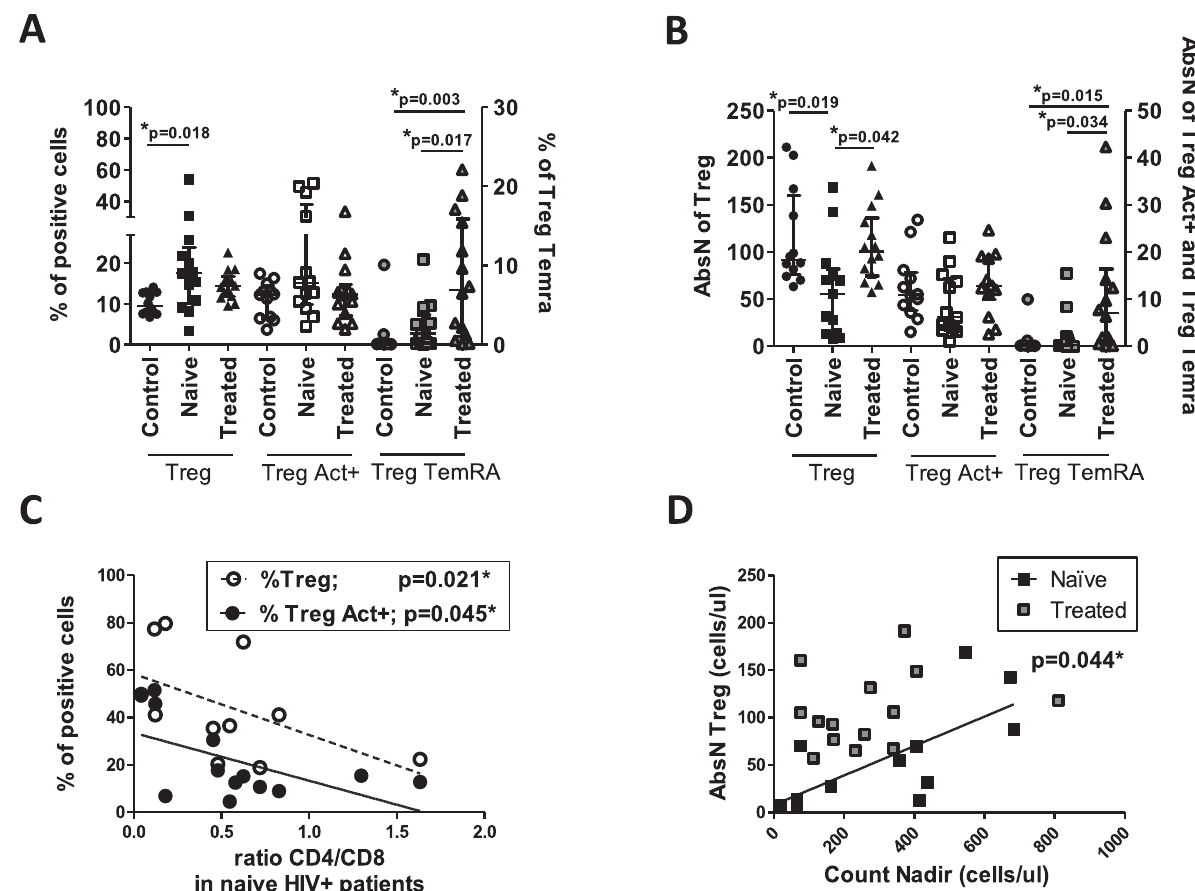
Fig 1. Alteration of Treg compartments in HIV+ and healthy individuals. (A) Frequencies and (B) absolute numbers (AbsN) of Treg, activated Treg (Treg Act + : CD25 + CD127 neg HLA-DR + CD45RO + ) and Treg TemRA (CD25 + CD127 neg CD27 neg CD45RA + ) were determined in whole blood using cell surface labeling. Frequencies of total Treg were obtained relative to CD4 + T cells and frequencies of Treg subsets were obtained relative to CD25 + CD127 neg . (C) Correlation between frequencies of total Treg or Treg Act + and the ratio CD4/CD8 in HIV + treatment-na ï ve individuals. (D) Correlation between absolute counts of Treg (AbsN Treg) and nadir count (black squares: HIV + treatment-na ï ve individuals and grey squares: treated-HIV + individuals). Medians ± IQRs are represented. Correlations were determined by Spearman’s rank correlation. Control: Healthy individuals. Na ï ve: HIV+ treatment-na ï ve individuals. Treated: Treated-HIV+ individuals. � = p < 0.05 when comparing conditions. Each symbol corresponds to an individual.